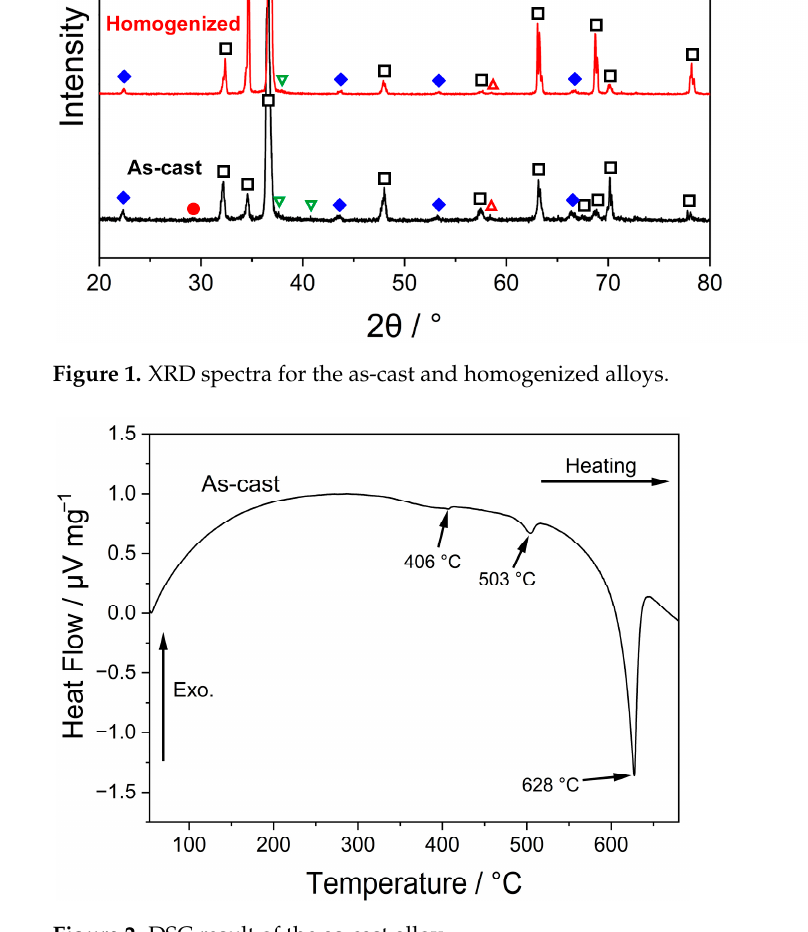
Figure 2. DSC result of the as-cast alloy. The optical microstructures and the grain size distribution histograms of the as-cast and homogenized GZX220 alloy are displayed in Figure 3. The as-cast alloy consisted of α -Mg grains and intermetallic particles, which formed somewhat a partially connected network throughout the microstructure. Upon homogenization treatment at 400 ◦ C, some of these particles dissolved partially into the matrix